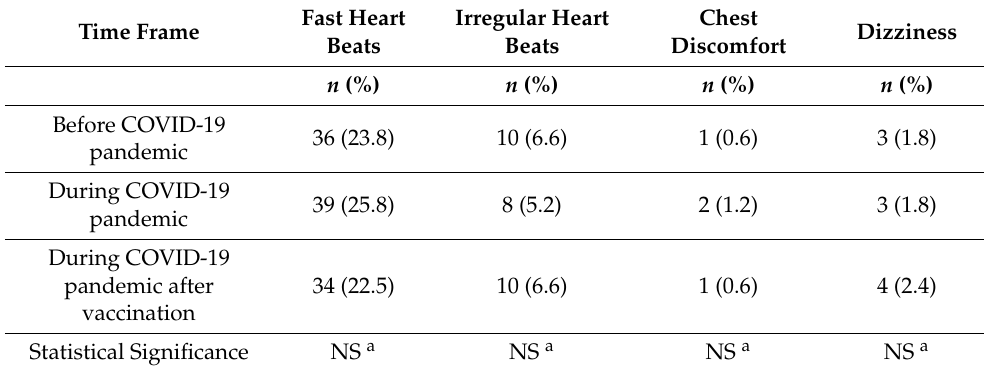
Table 3. Causes for ECG sensor placement.